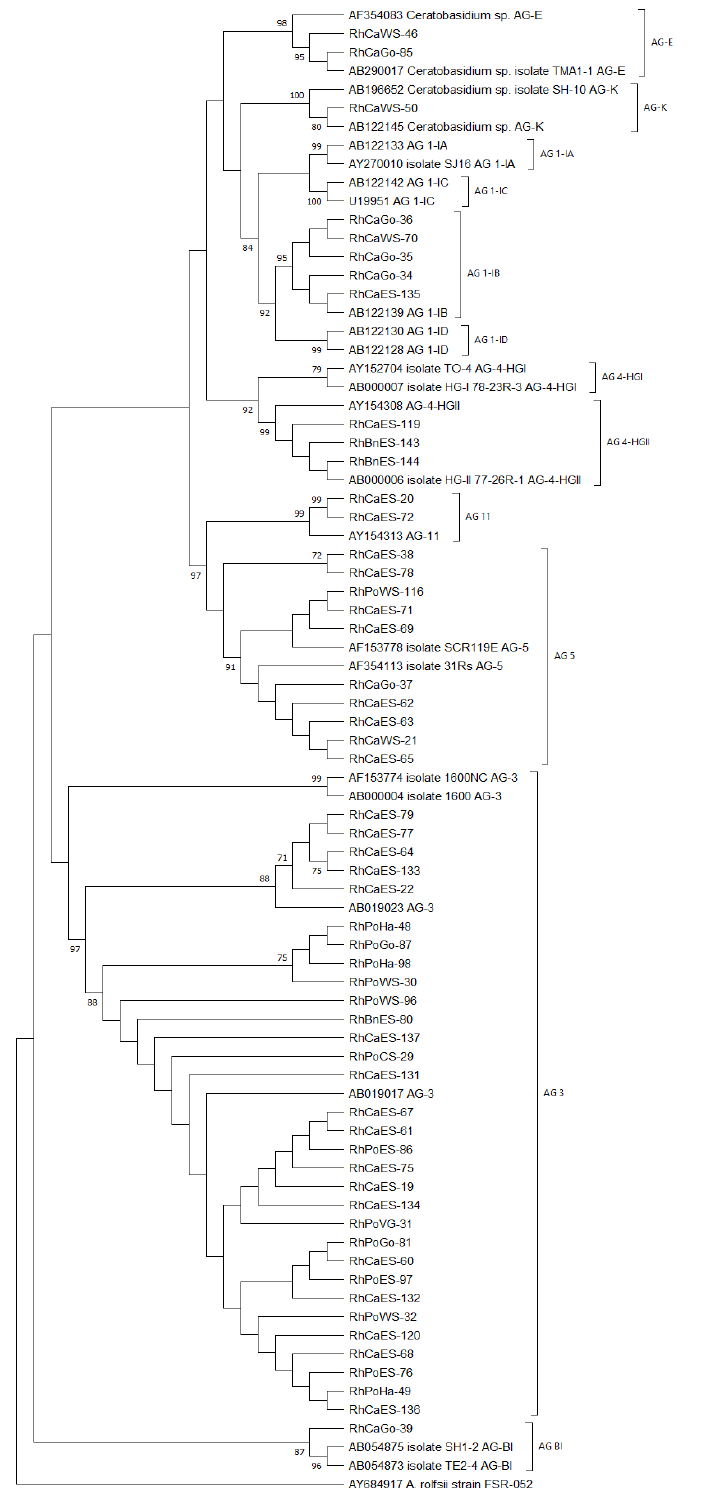
Figure 4. rDNA-ITS phylogeny of 52 multinucleate Rhizoctonia solani spp. and 3 binucleate Ceratobasidium spp. sampled from potato, carrot and black nightshade grown in different regions of Sweden. The maximum likelihood tree is derived from the alignment of these 55 Rhizoctonia isolates, 24 reference isolates from Sharon et al. [7] and the outgroup Athelia rolfsii (AY684917). Isolates with the Rh prefix were obtained from Sweden. Bootstraps are only given for those branches with bootstrap support higher than 70.